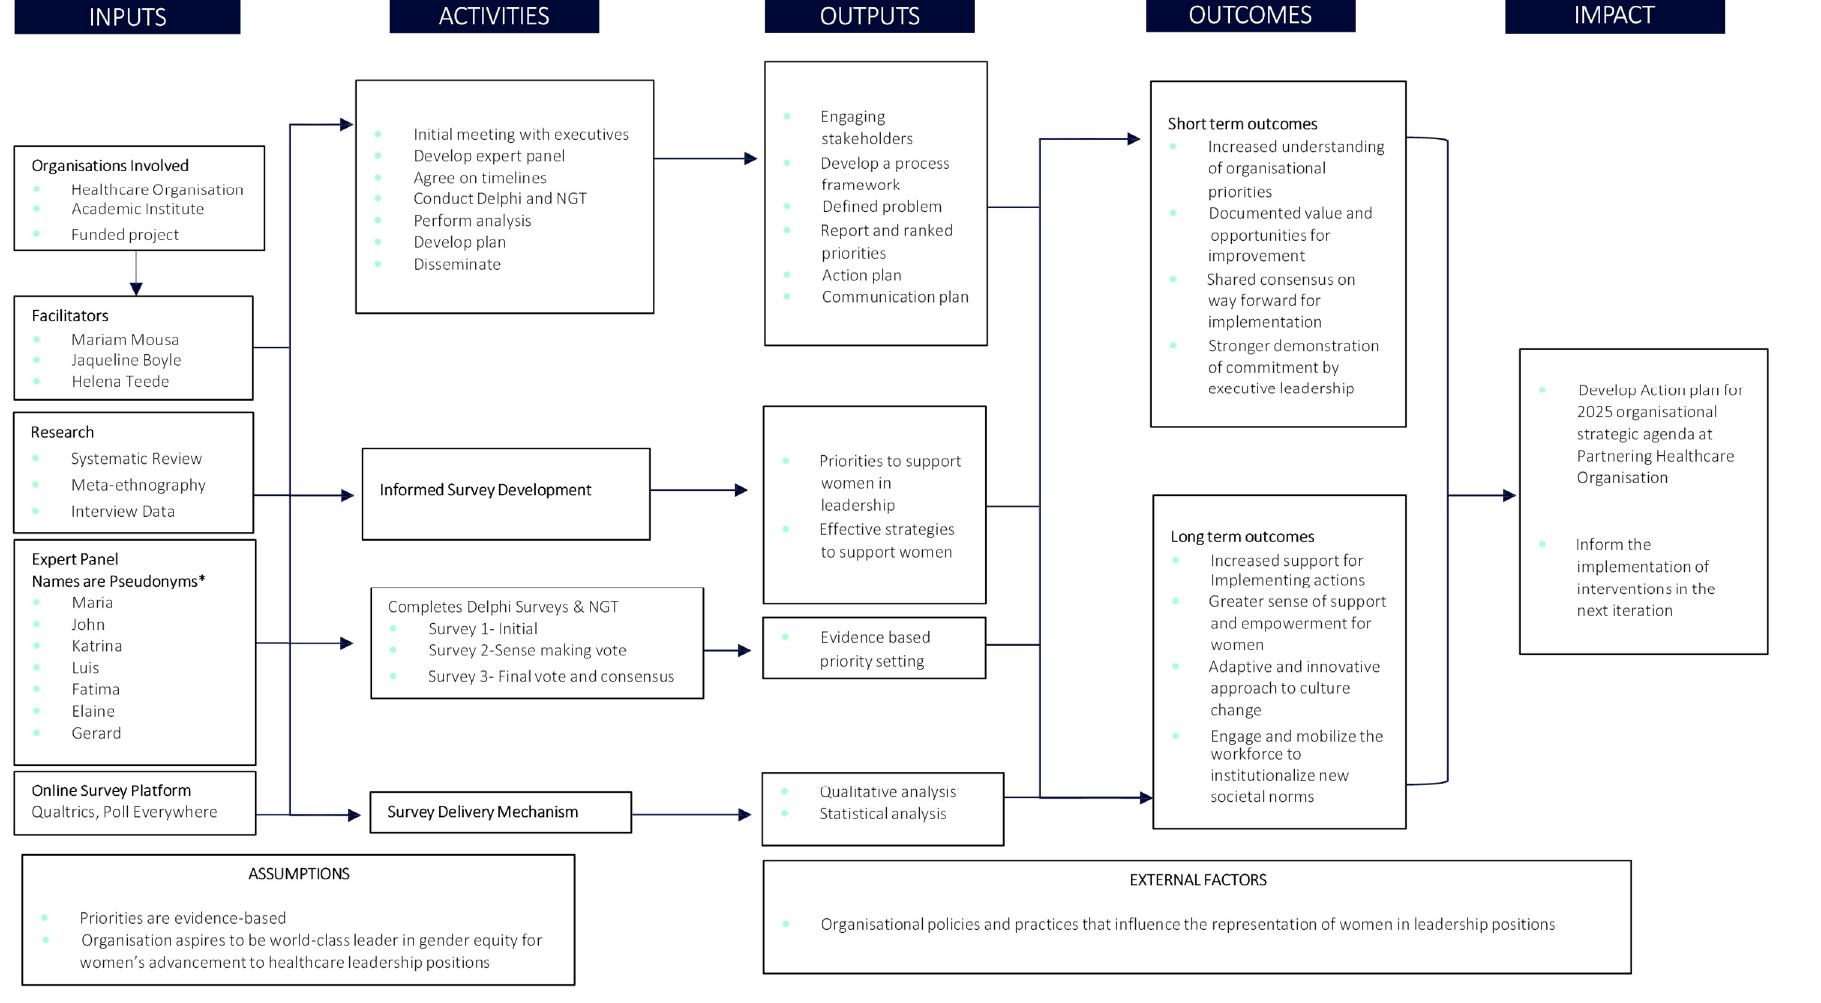
Figure 1. Priority Setting Program.